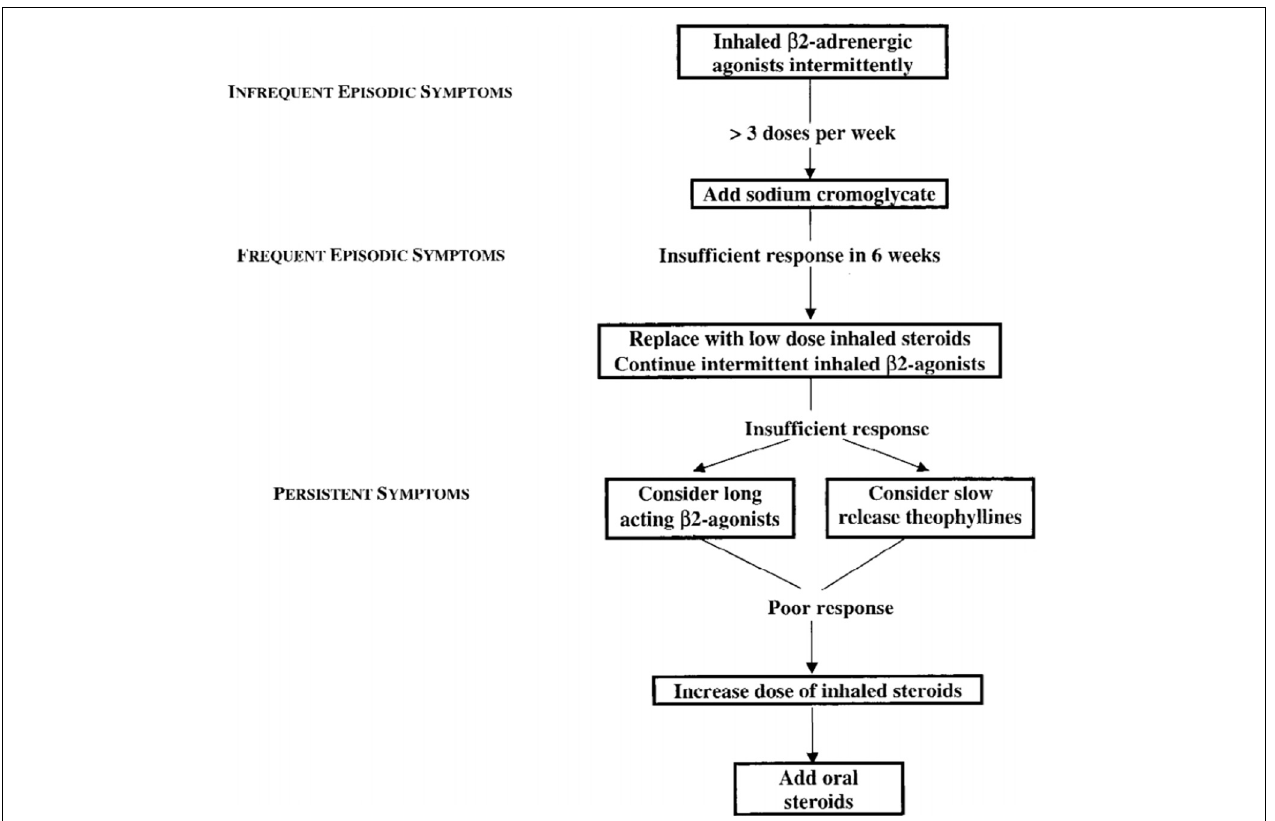
FIGURE 2 | 1998 International Pediatric Consensus statement on the management of childhood asthma – flow chart (33).